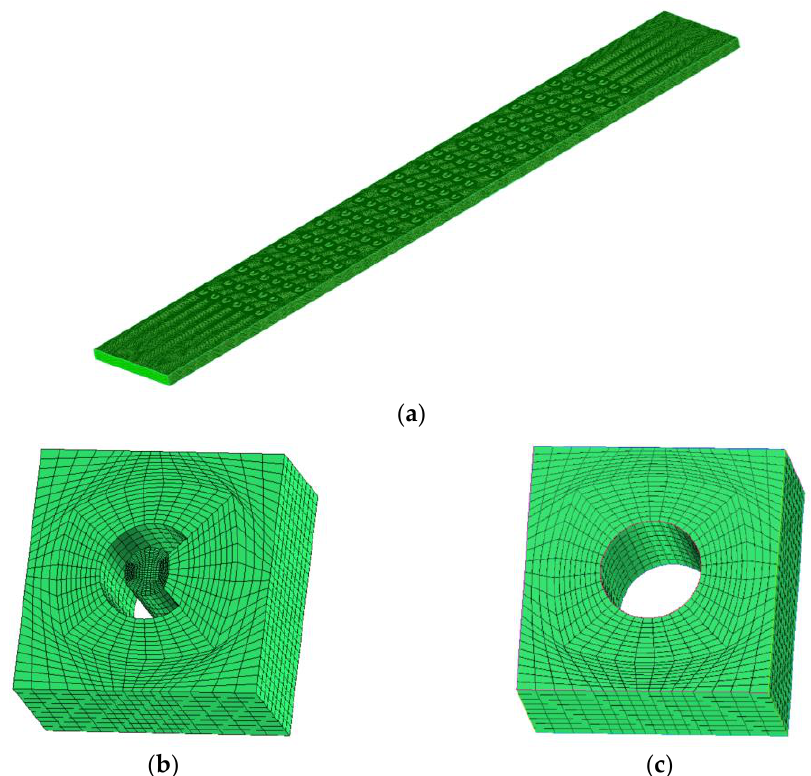
Figure 2 . Computational domain with mesh. ( a ) Computational domain with mesh; ( b ) Zoomed-in view around the ring-shaped micro-pin-fin; ( c ) Zoomed-in view around the circular micro-pin-fin.